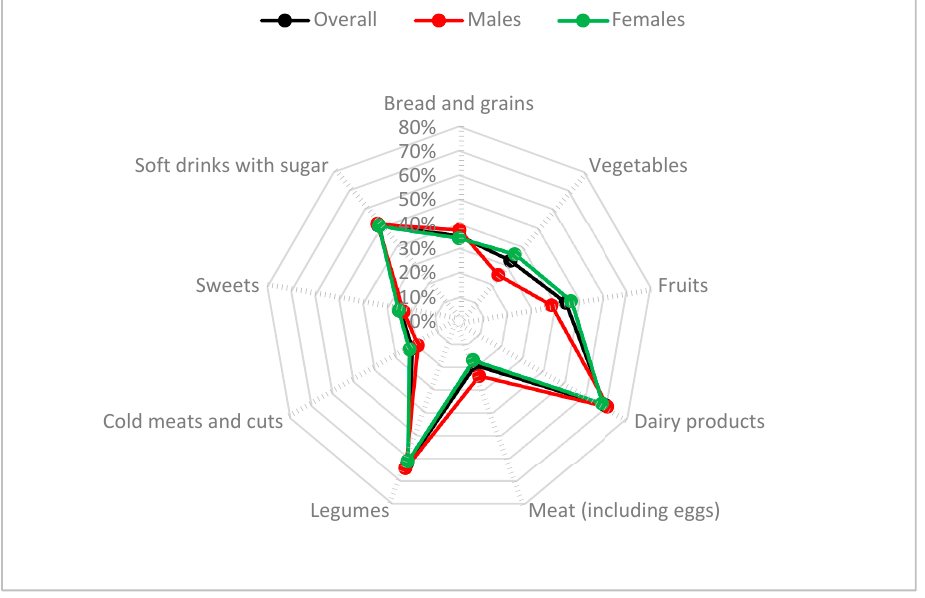
Figure 2. Percentage of students who adhere to the NFBDG-2016 [31] recommendations for the frequency with which certain foods should be consumed every week. Table 1. Participant characteristics ( n =